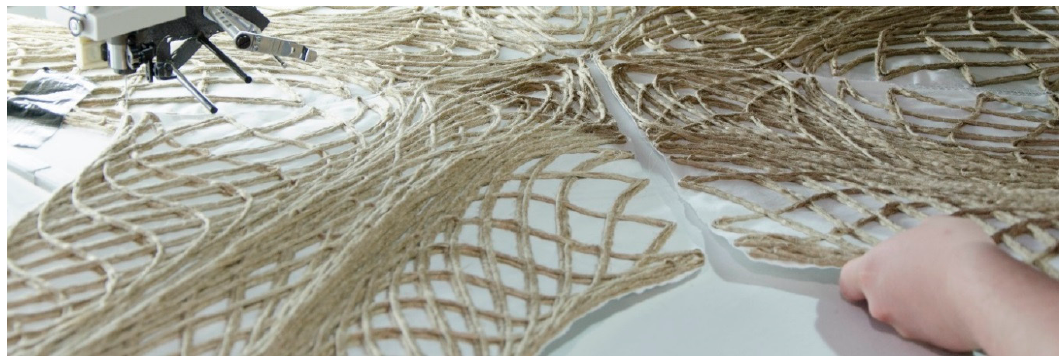
Figure 14. Placing the last fifth of the third prototype on the TFP machine for the connection.